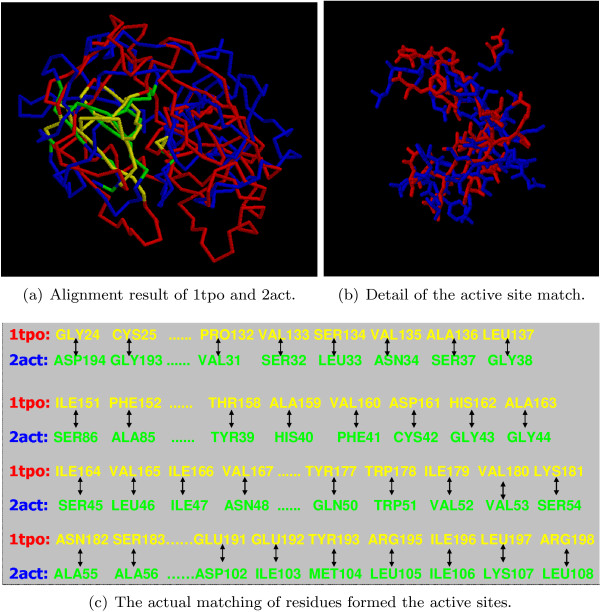
The comparison result of protein pair 1TPO/223 (β-trysin) and 2ACT/218 (actinidin) by SAMO. Subfigure (a) illustrates the aligned result after the optimal superimposing by different colors. The red chain is 1TPO and the blue chain is 2ACT. There are 122 amino-acid matching pairs with RMSD = 2.02. Also the active site region on 1TPO is highlighted in yellow and the active site region on 2act is drawn in green. Subfigure (b) is the detail match of the active sites between 1TPO(red) and 2ACT(blue). As indicated in the figure, the superposition of Cαs found by SAMO brings the catalytic triads close together. In the matched active sites, the amino acids come from different fragments of each protein chain. Some segments contain contiguous residues. The actual matching of these segments is, for 2ACT: 24–25, 151–152, 132–137, 158–167, 177–183, 191–198; for 1TPO: 194–195, 85–86, 31–36, 39–48, 50–56, 101–108. The actual matching of the residues formed the active sites is listed in Subfigure (c).